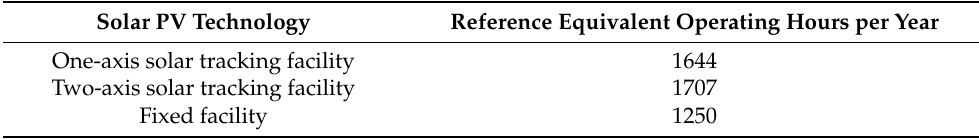
Table 9. Reference equivalent operating hours for PV power plants under RD 661/2007 until 31 December 2013 set by RDL 14/2010. Source: self-elaboration based on